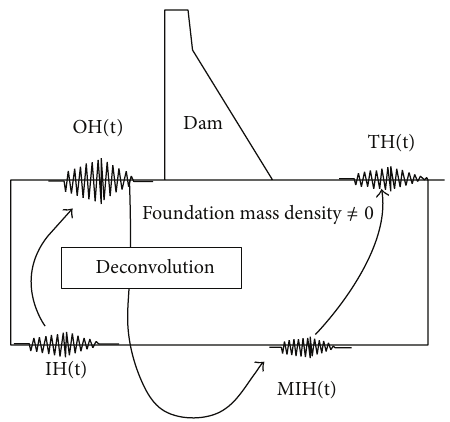
Figure 1: Representation of deconvolution